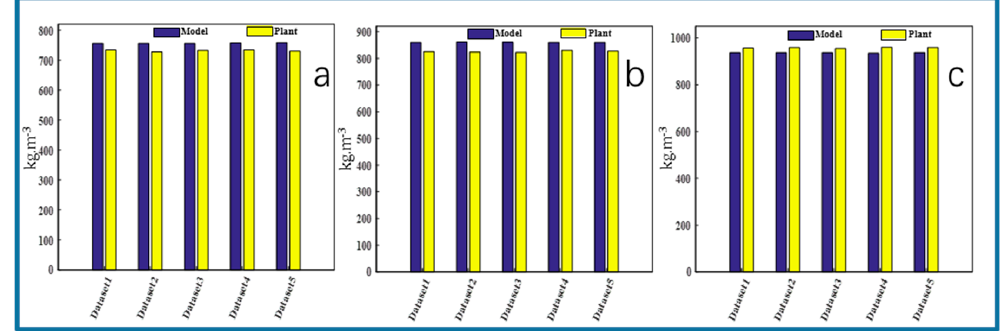
Figure 17. Predictions of ASTM D86 distillation curves of liquid products: ( a ) Dataset 1; ( b ) Dataset 2.